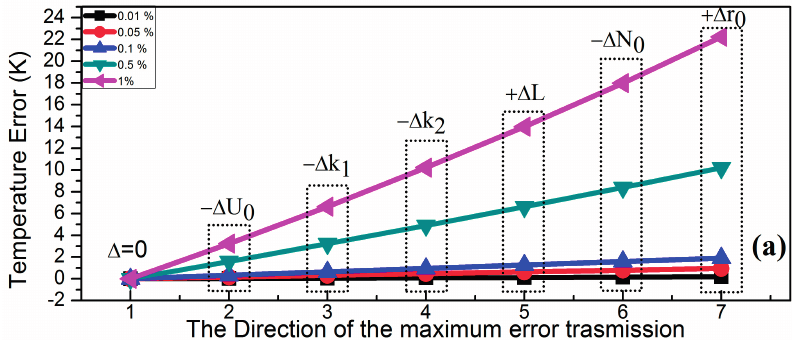
Figure 5. Temperature measurement error resulting from parameters, such as the turns of the detection coil ( n 1 = 884, n 2 = 884), the cross-sectional area of the detection coil ( s 1 = 58.99 mm 2 , s 2 = 58.99 mm 2 ), the voltage gain of the preamplifier ( k 3 = 1000) and the DC bias of the preamplifier ( c 1 = 8.2 mV). The deviation rates of the parameters are 0.01%, 0.05%, 0.1%, 0.5% and 1%, respectively. The mean particle diameter is 10 nm; the saturation magnetic moment is MsV = 2.4976 × 10 − 19 emu; the magnetic excitation frequency is 375 Hz; the system has no noise and no AC